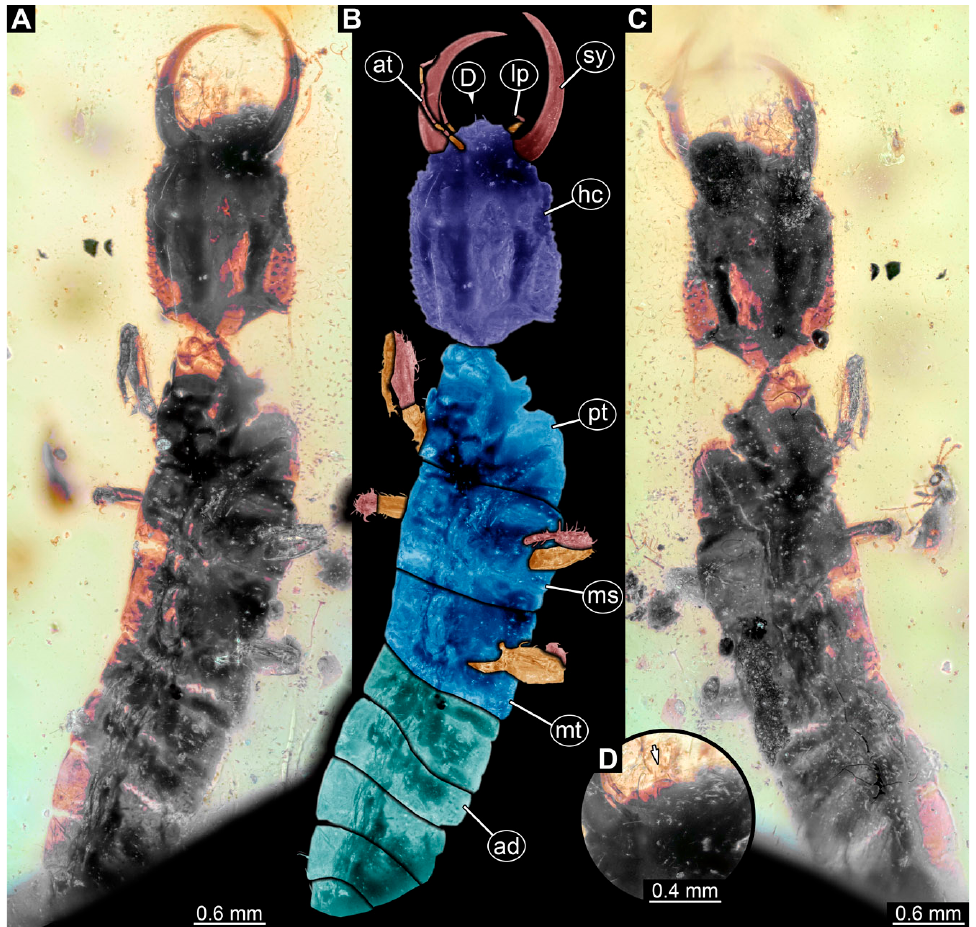
Figure 29. Specimen 96 (PED 2432); Myanmar amber. ( A ) Ventral view. ( B ) Ventral view, colour-marked. ( C ) Dorsal view. ( D ) Close-up of labrum; arrow marks labrum. Abbreviations: ad = abdomen; at = antenna; hc = head capsule; lp = labial palp; ms = mesothorax; mt = metathorax; pt = prothorax; sy = stylet.